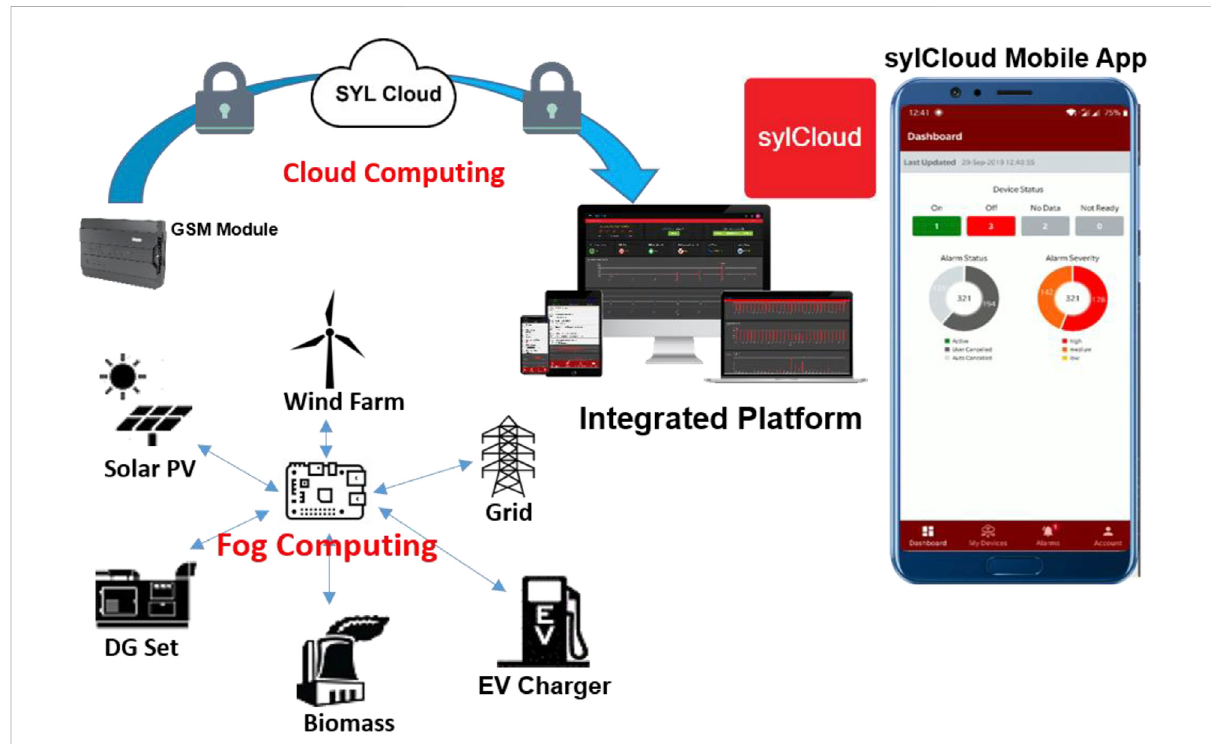
FIGURE 6 Applications of IoT in intelligent power grids (Khatua et al.,